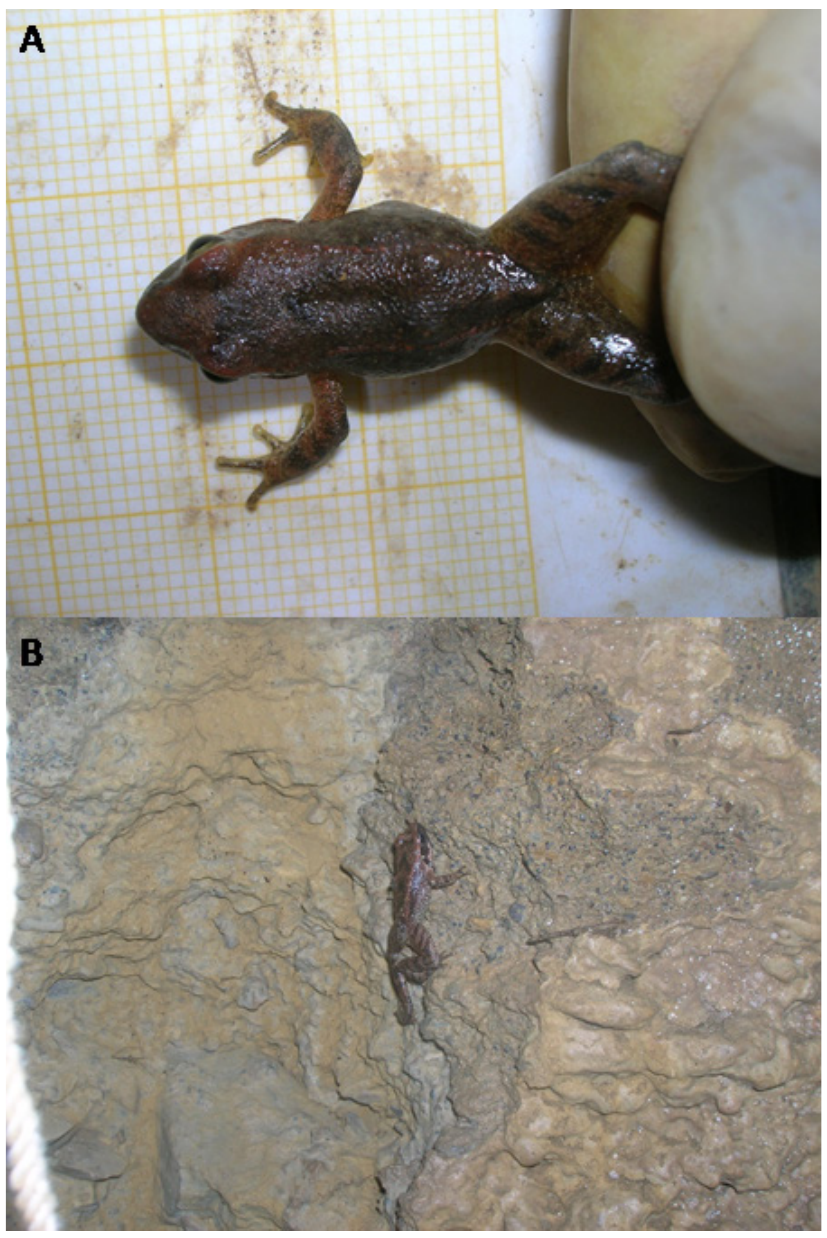
Figure 1. Two juveniles of Rana italica : a) during the measurement of SVL and b) climbing cave walls. P = 0.006) and Limonia nubeculosa ( F = 5.50, P = 0.019). Overall, frogs were more 1,730.17 abundant in shallow sectors with less light and warmer temperature, and with the presence of both D. laetitiae and L. nubeculosa . Furthermore, we detected significant differences